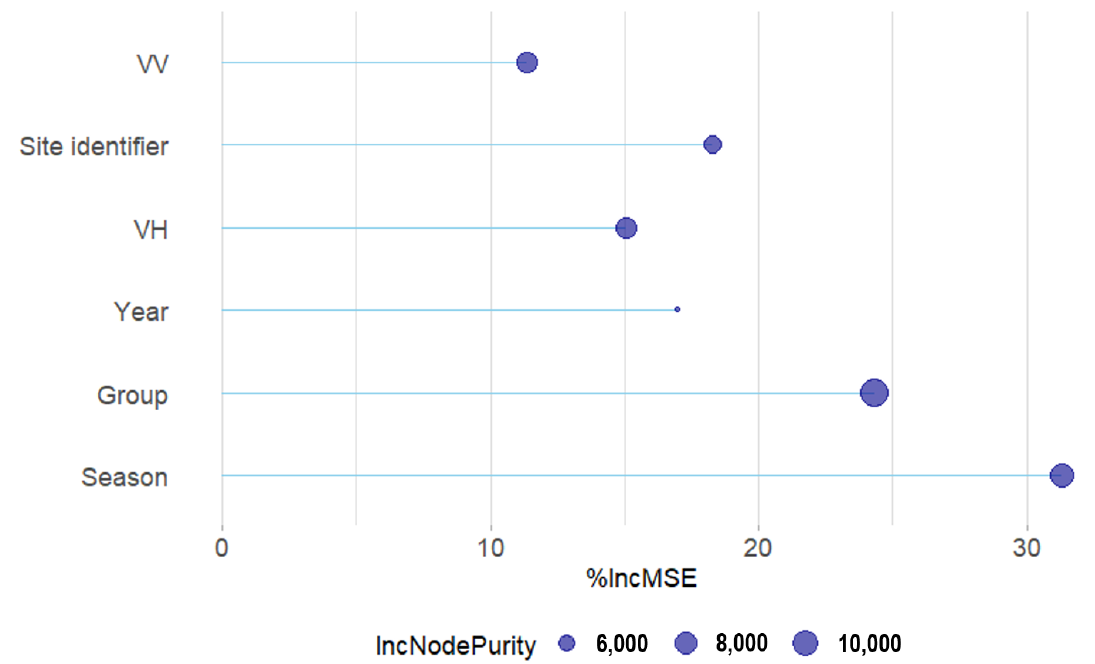
Figure 10. Random forest model variable importance for the WTD prediction. The percentage increase in the mean square error (%incMSE) is shown on the x axis, and the circles represent the increase in node purity. The smaller these two parameters, the less change observed in the model when a specific variable was removed or added. The variable ranking shows well how valuable the inclusion of categorical variables was for the improvement of the WTD prediction.